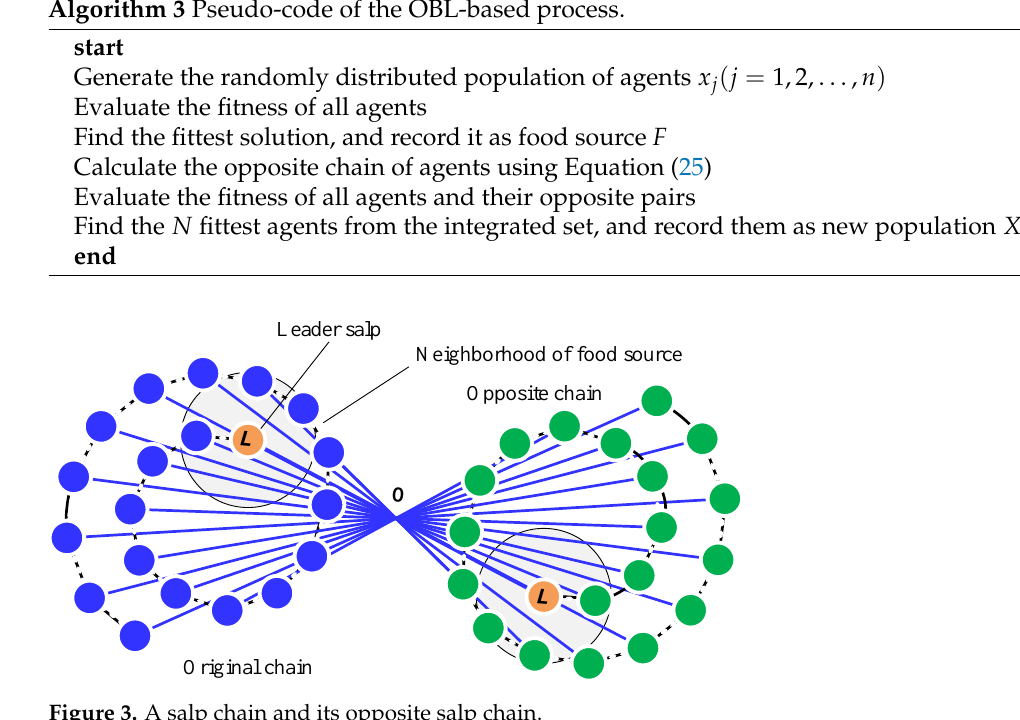
Figure 3. A salp chain and its opposite salp